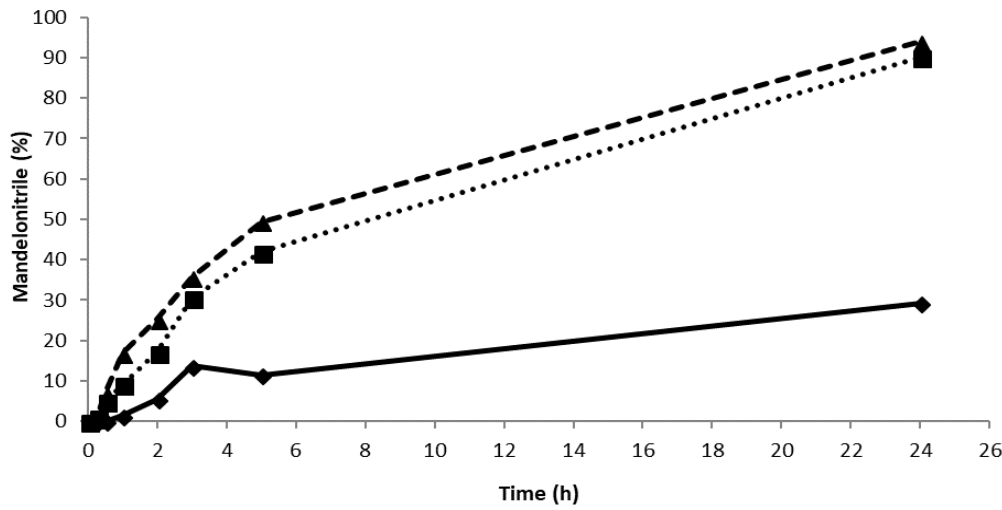
Figure 3. The synthesis of mandelonitrile using Pa HNL with different enzyme/support ratios. Conditions: benzaldehyde (±106 mg, 1 mmol), 2 mL HCN solution in MTBE (1.5 M), 1,3,5 ‐ triisopropylbenzene (±25 mg, internal standard) and a small, tightly packed teabag filled with Pa HNL ‐ immobilized on Celite R ‐ 633. The teabags contained 50 mg of Celite with an enzyme/support ratio of 1 U/mg ( ◆ and solid line; final ee = 81%), 2.6 U/mg ( ■ and dotted line; final ee = 89%) and 6.5 U/mg ( ▲ and dashed line; final ee = 89%). The solution was stirred at 900 rpm at room temperature.